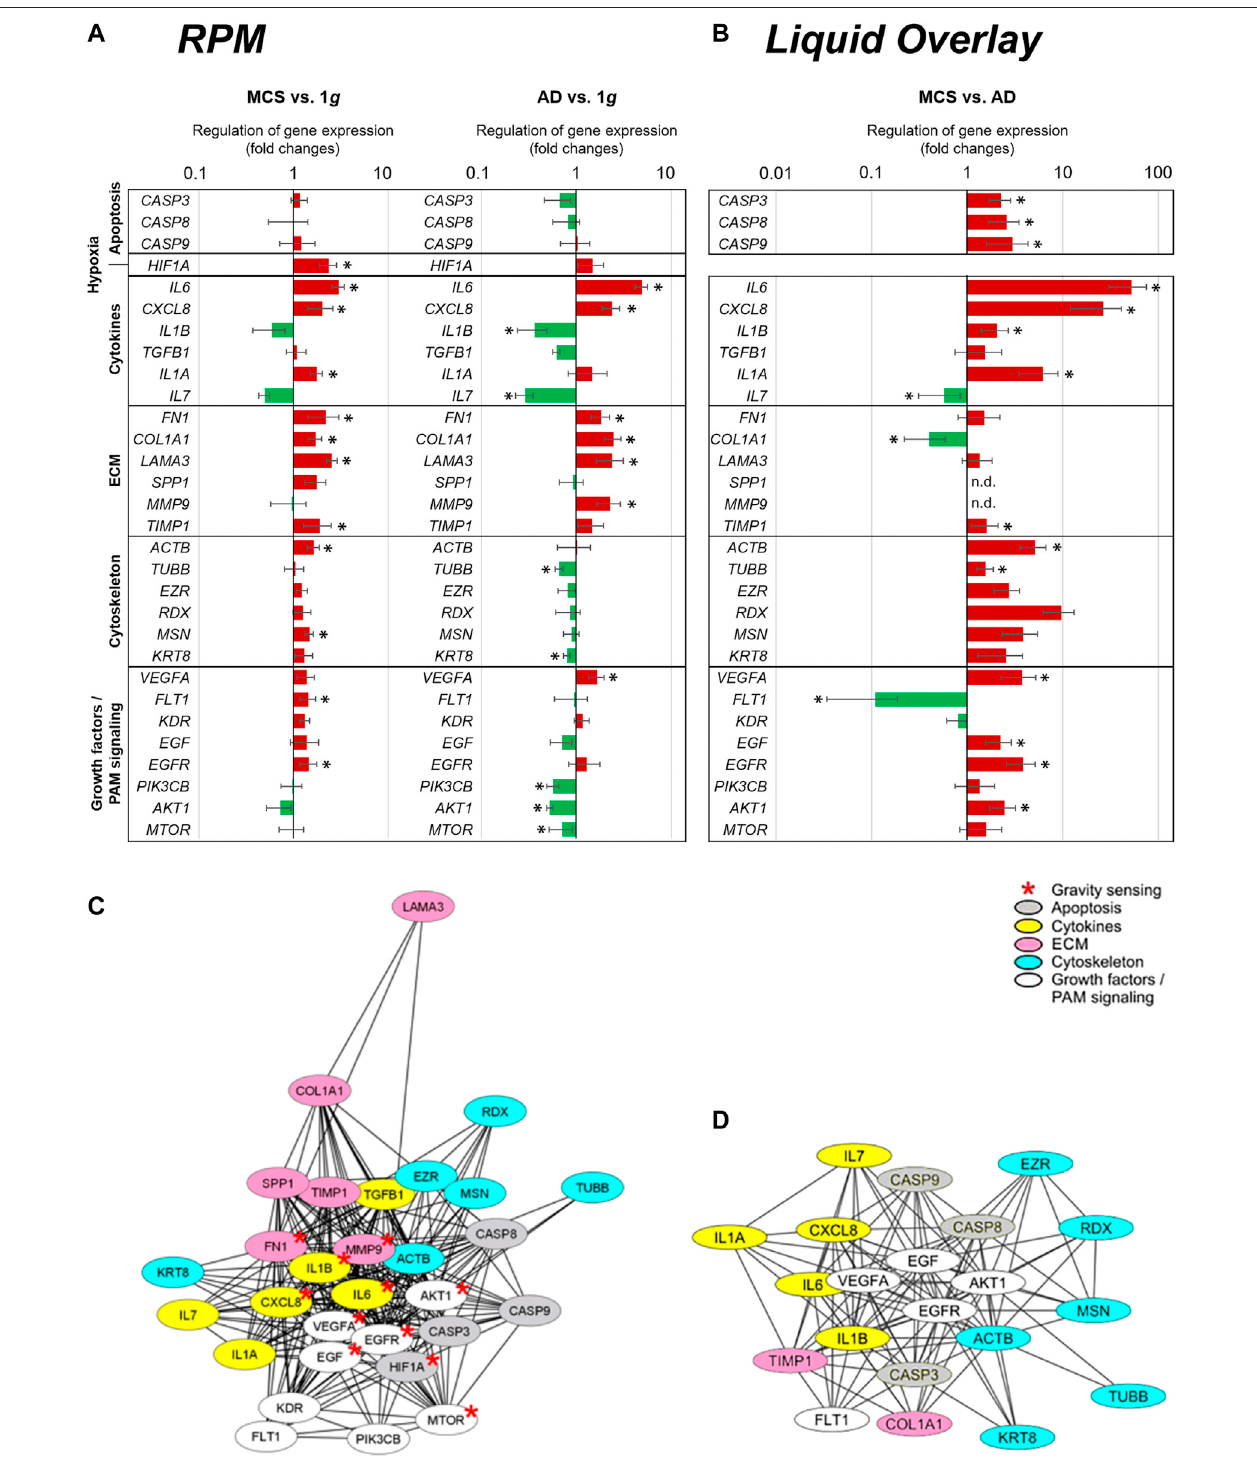
FIGURE 8 | qPCR expression changes of selected genes and their relationship in STRING protein-protein interaction networks. (A) qPCR gene expression fold changes of the 24 h RPM-exposed PC-3 samples (AD and MCS) in relation to 1 g . The red and green colors indicate upregulated and downregulated genes in RPM-exposed samples respectively. Signi fi cant regulations are indicated by black asterisks ( p < 0.05). (B) qPCR gene expression fold changes of liquid overlay derived MCS cell aggregates in relation to controls. (C,D) Network of the functional interaction of genes and their products (C) analyzed in this study and (D) differtially regulated in liquid overlay derived MCS cell aggregates. The analysis was performed by STRING 11.0 (https://string-db.org/) and combined scores are visualized by Cytoscape 3.8.2. Af fi liation to functional gene groups is color-coded. Red asterisks indicate genes known to be involved in prostate cancer gravity sensing.